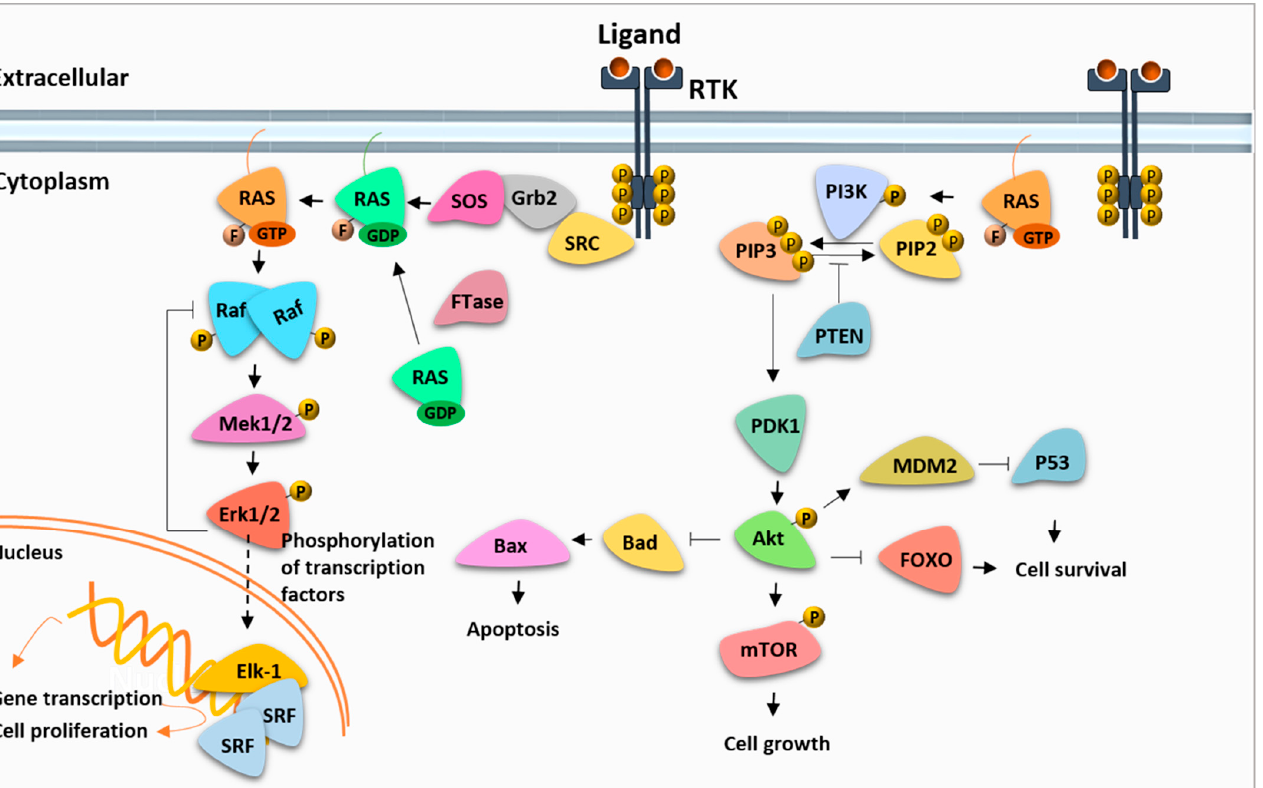
Figure 1. Ras/Raf/MEK/Erk and PI3K/mTOR signaling pathways.